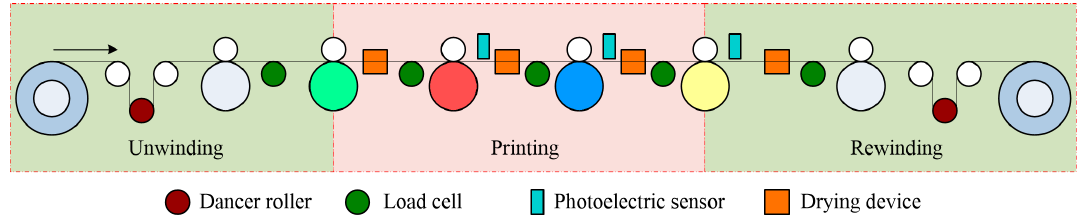
Figure 1. Diagram of a roll-to-roll gravure printed electronics machine.